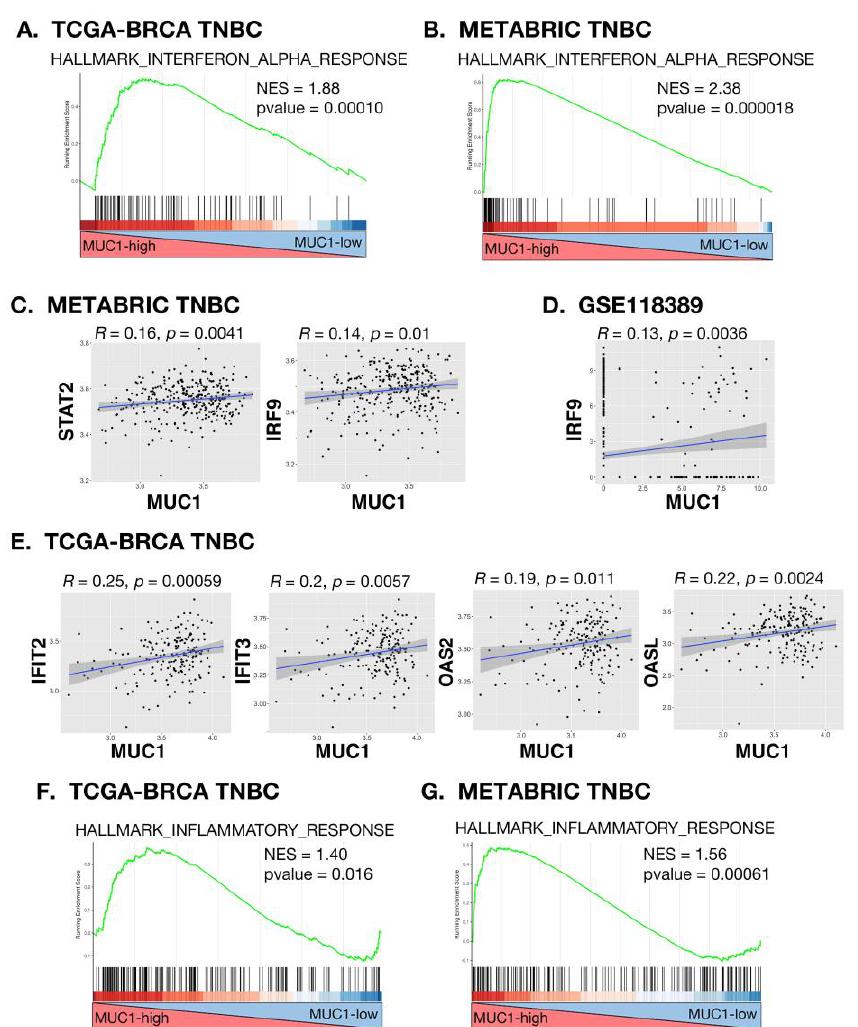
Figure 1. MUC1-high TNBC tumors associate with type I IFN and inflammatory signaling pathways. ( A , B ) Enrichment plots for the HALLMARK INTERFERON ALPHA RESPONSE pathway, compar- ing MUC1-high to MUC1-low TNBC tumors in the TCGA-BRCA ( A ) and METABRIC ( B ) cohorts. ( C ) Scatter plots showing correlations of MUC1 with STAT2 and IRF9 in TNBCs from the METABRIC cohort. ( D ) Scatter plot of the correlation between MUC1 and IRF9 in single TNBC cells as analyzed from the GSE118389 scRNA-seq dataset. ( E ) Scatter plots showing correlations of MUC1 with IFIT2, IFIT3, OAS2 and OASL in TNBCs from the TCGA-BRCA and METABRIC TNBC cohorts. ( F , G )